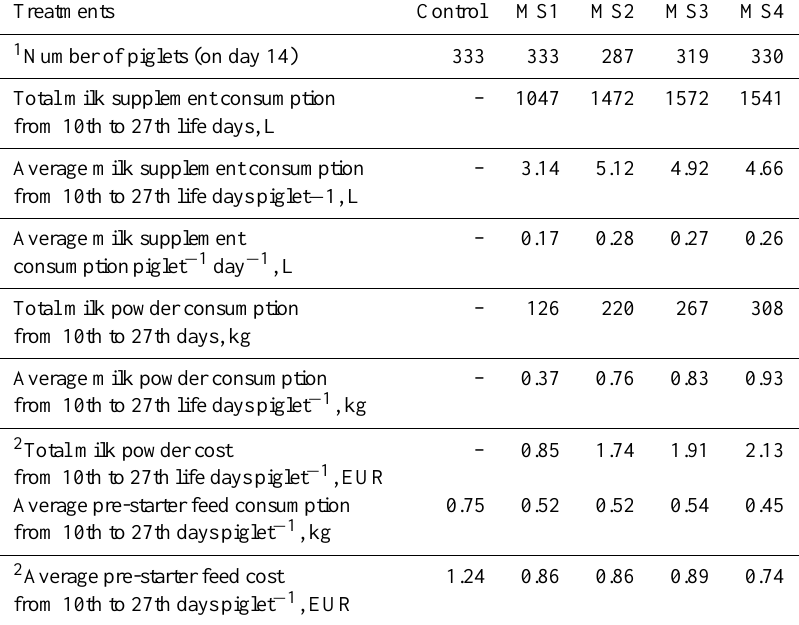
Table 1. Milk supplement and pre-starter feed consumption in different treatments. Treatments